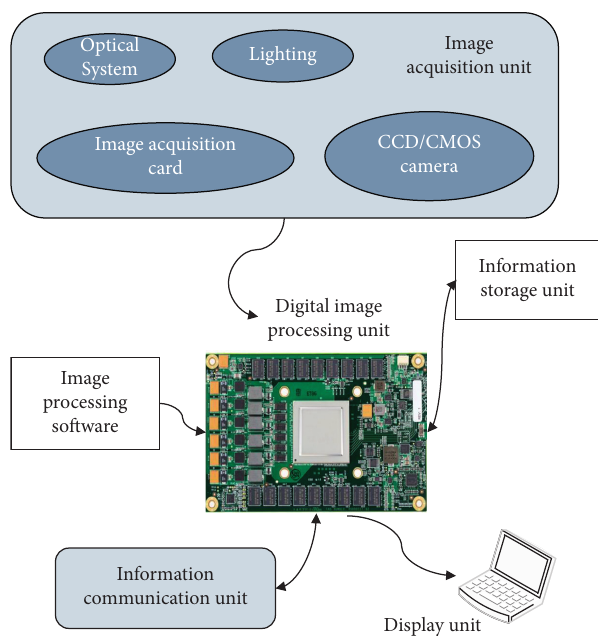
Figure 2: The working process of the visual sensor in the FAT animation production process.